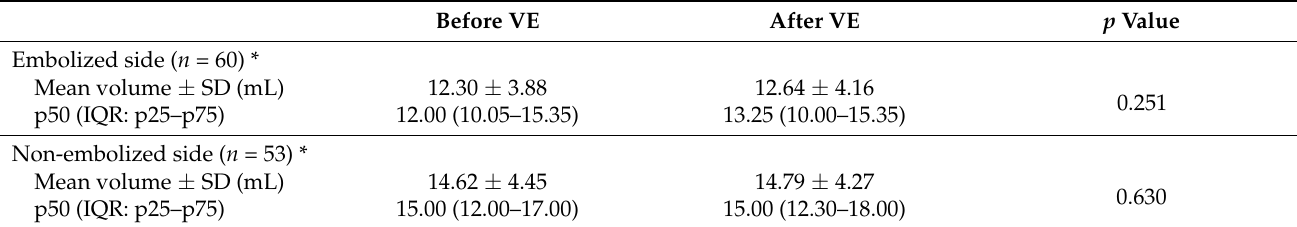
Table 9. Testicular volumes (mL) before and after varicocele embolization (VE). Before VE After VE p